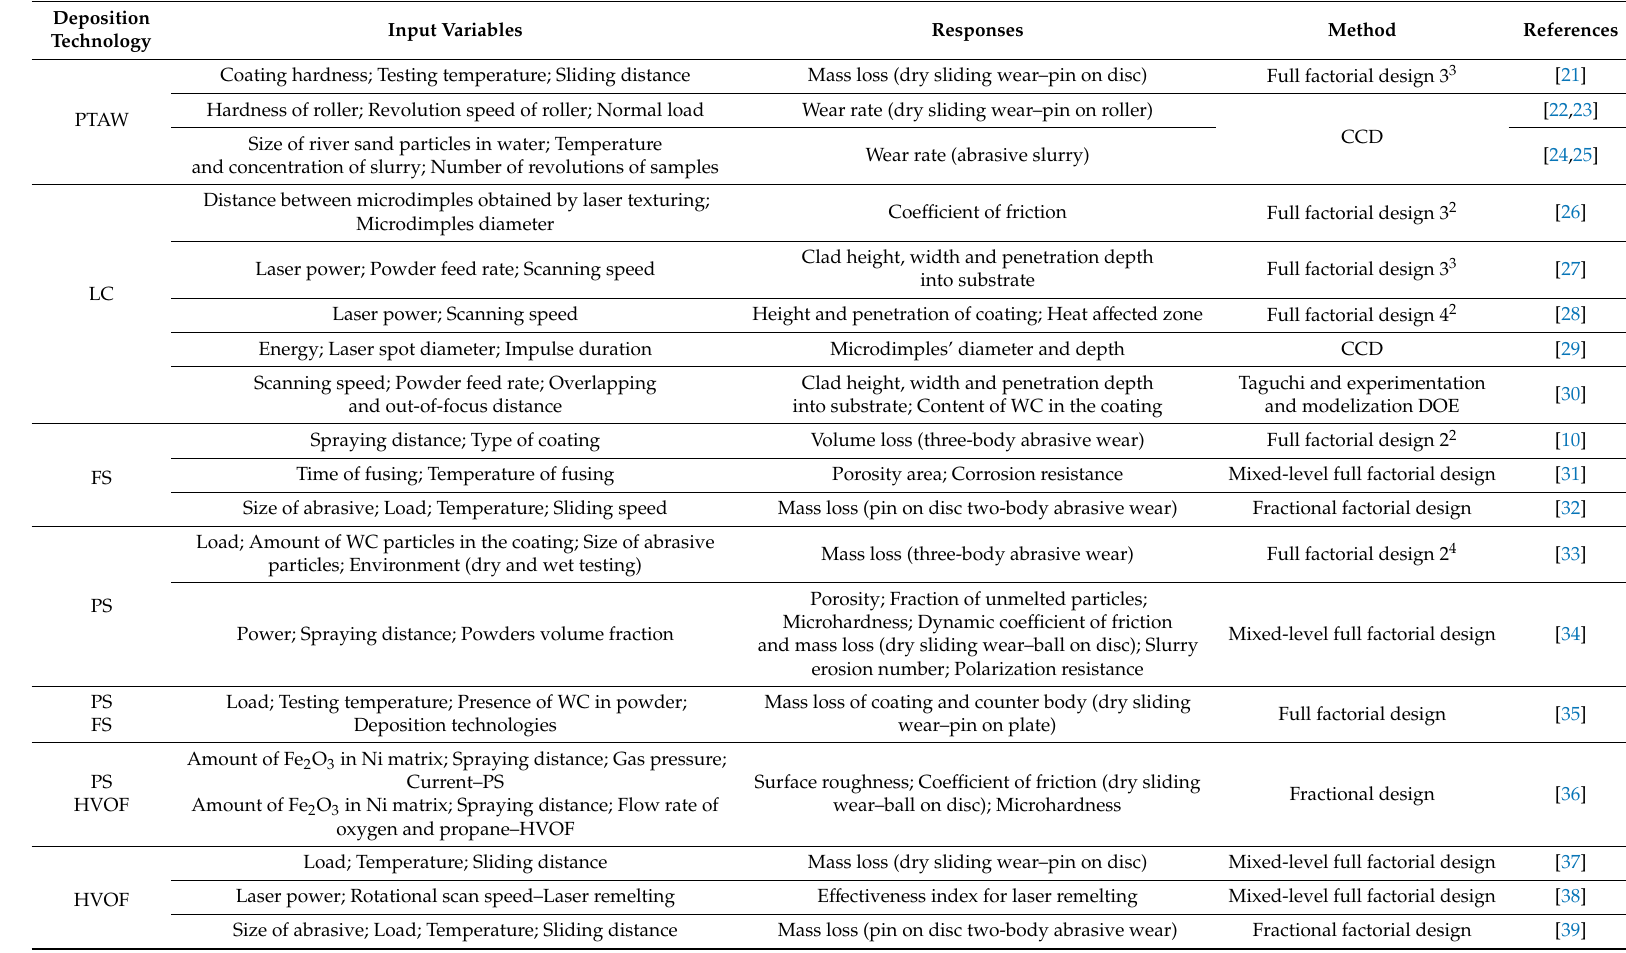
Table 1. Summary of investigations for the modeling